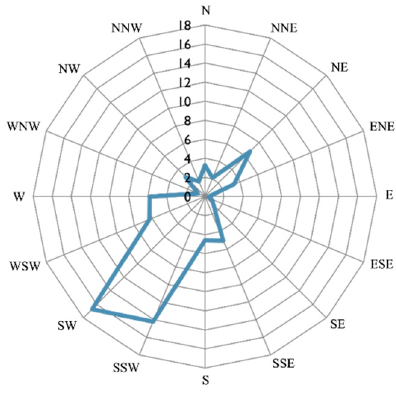
Figure 6. Wind rose characteristic of AZRF settlements in winter (according to RosHydroMet, the Russian meteorological service).